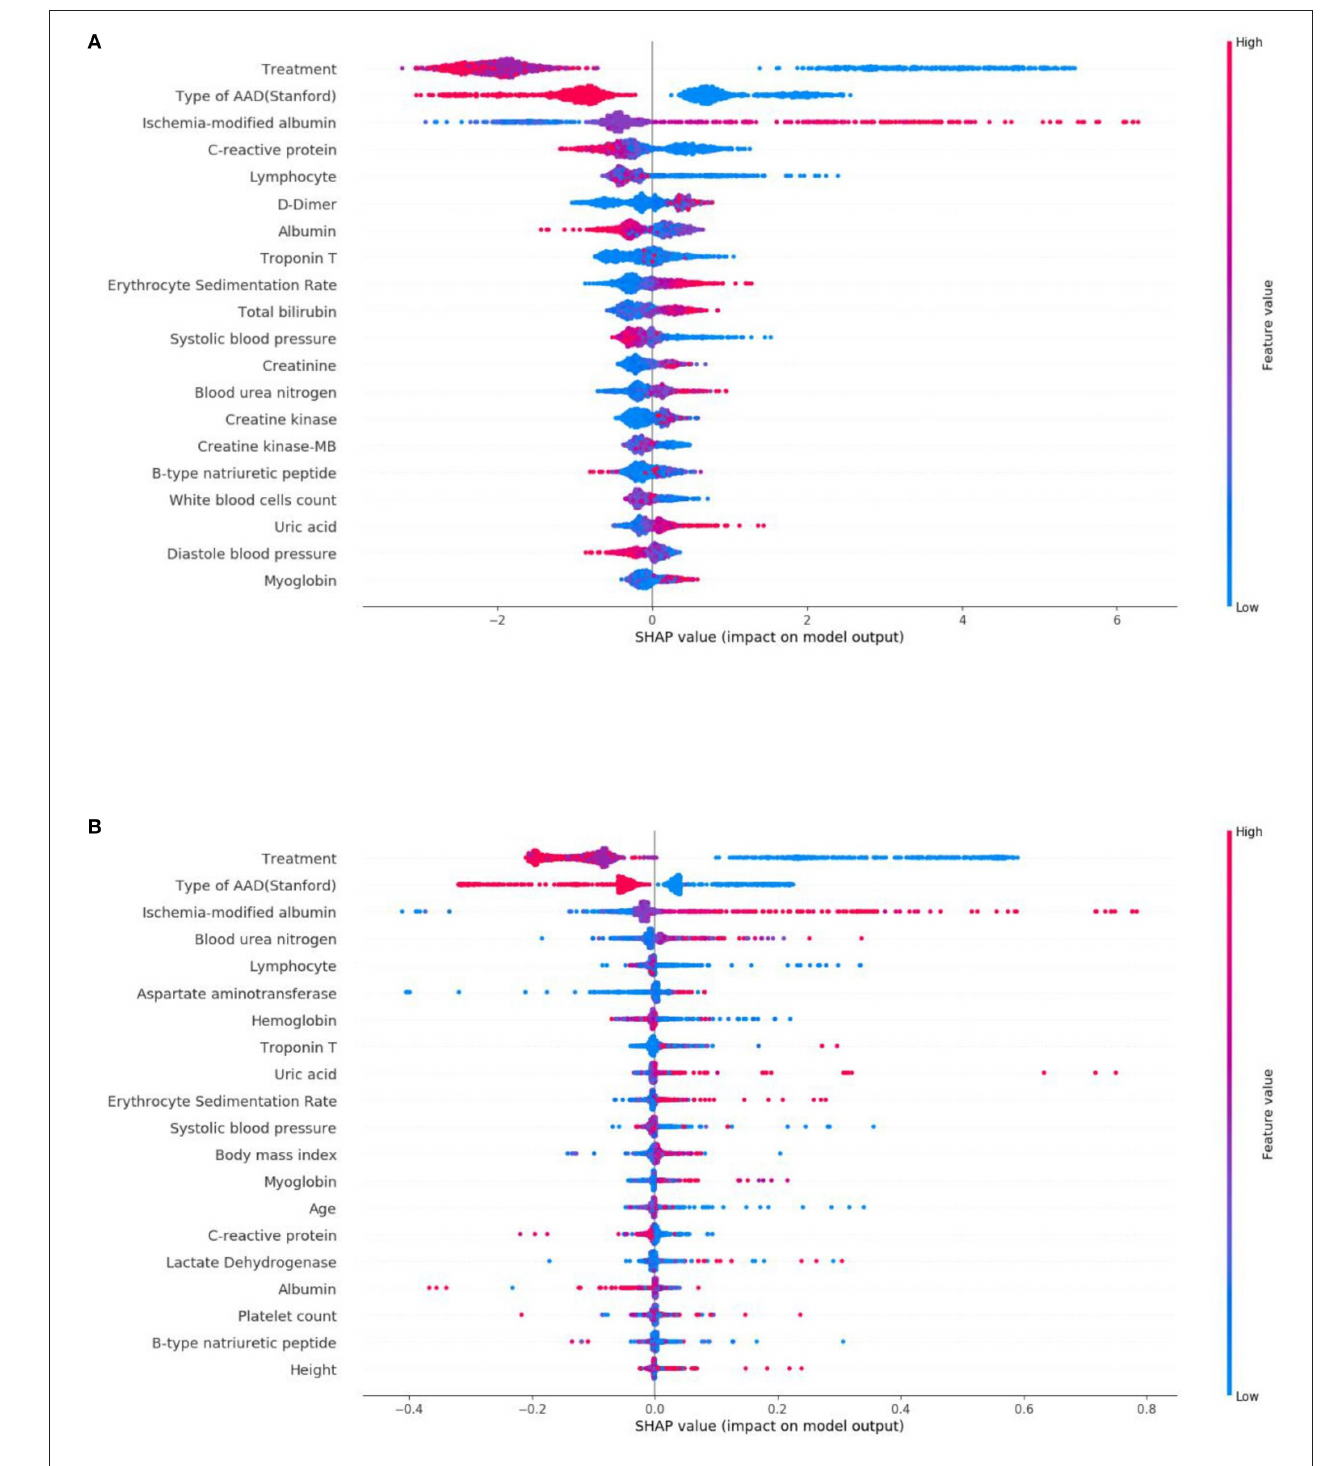
FIGURE 6 | SHAP summary plots of the top 20 features in the XGBoost model (A) and DT model (B) . The higher the SHAP value of a feature, the higher the risk of in-hospital mortality. A dot is shown for each feature attribution value for the model of each patient, and thus, one patient is allocated a single dot for each feature. Dots are colored based on the values of the features for the respective patient and accumulate vertically to depict density. Treatment was divided into three categorical features: medical treatment (blue), endovascular treatment (purple), and surgical treatment (red). Type of AAD (Stanford) was divided into two categorical features: Type A (blue) and Type B (red). For continuous features, red represents higher feature values, whilst blue represents lower feature values.